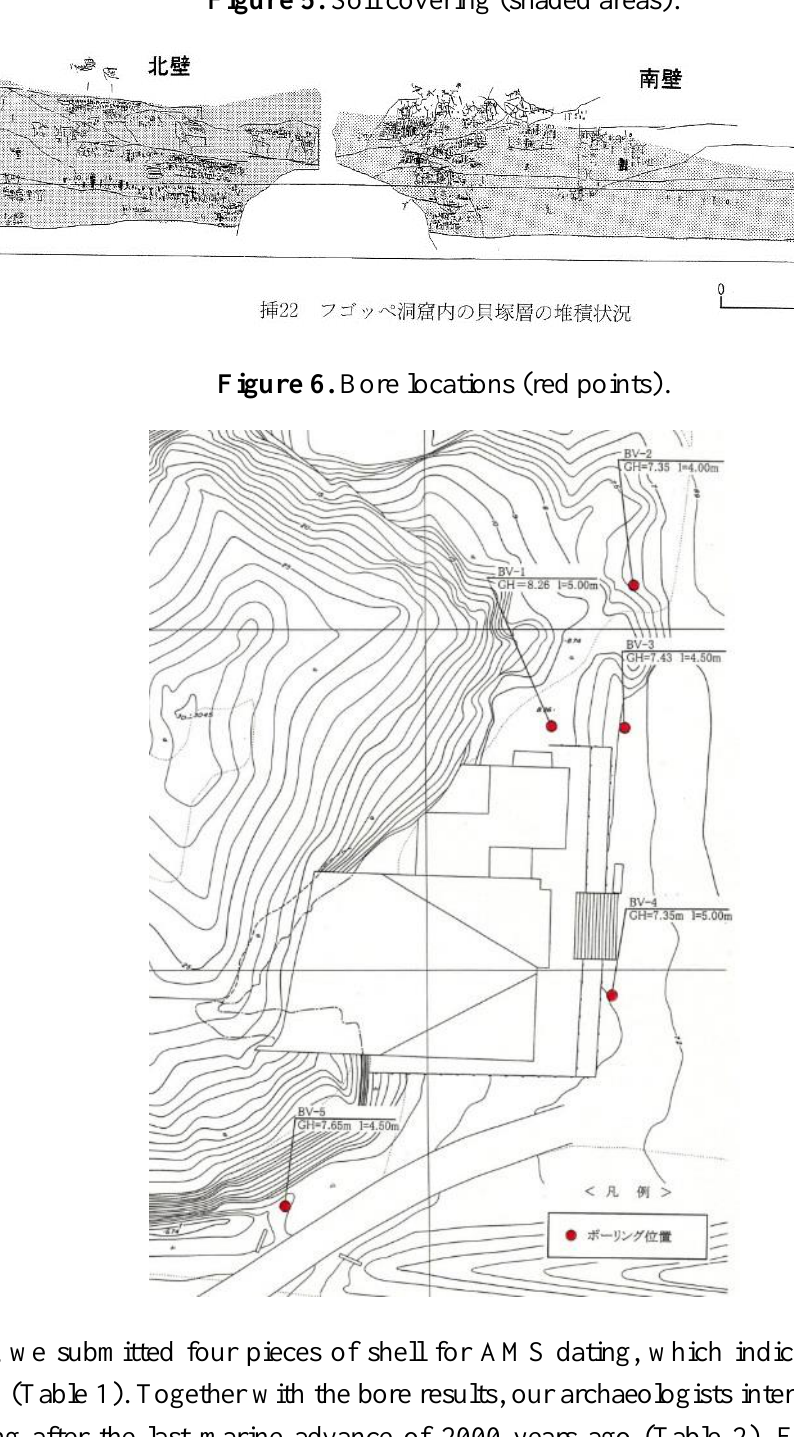
Figure 5. Soil covering (shaded areas).